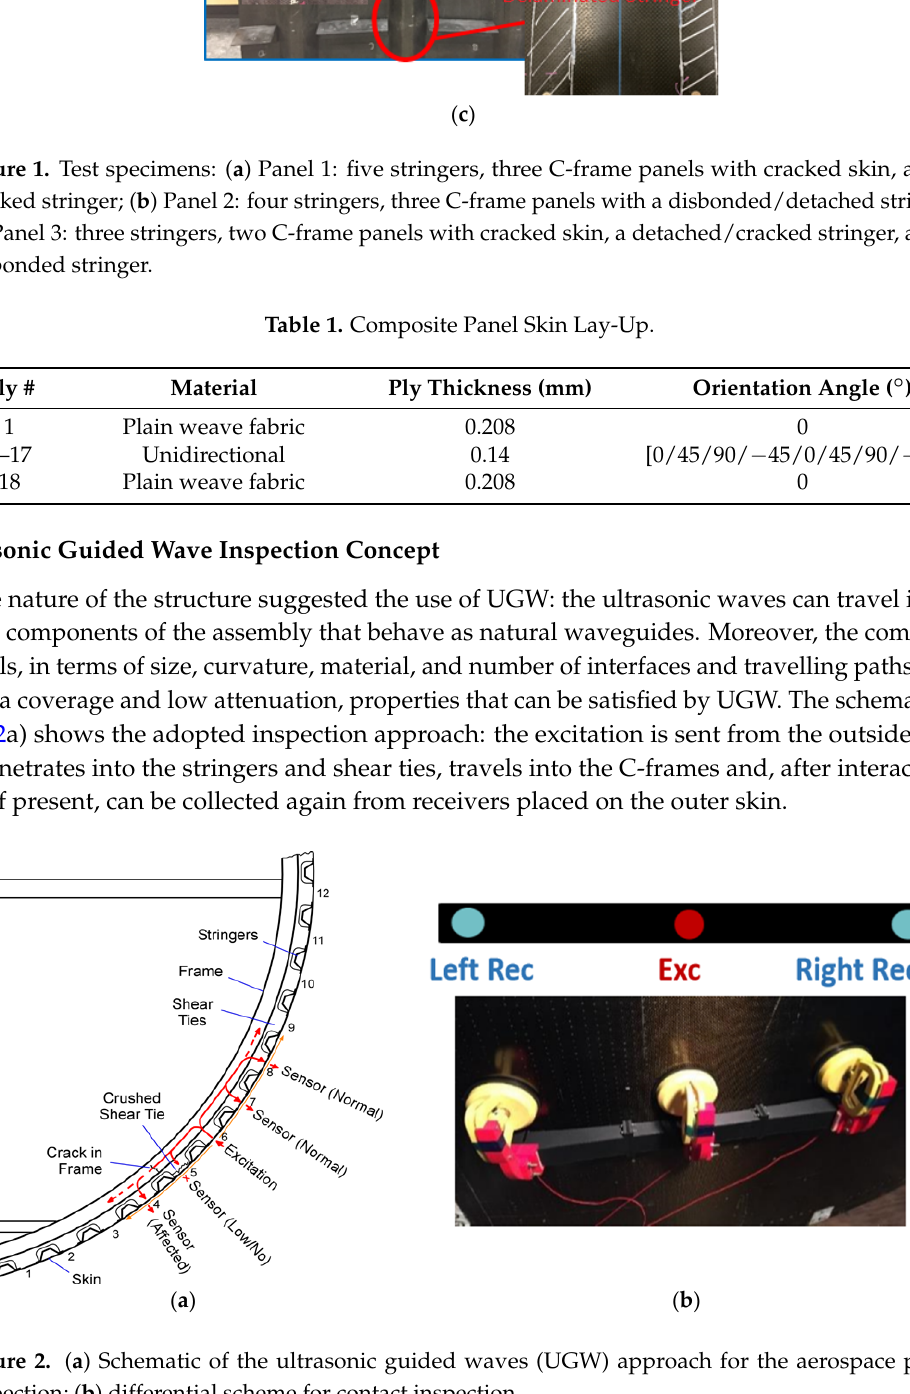
Figure 2. ( a ) Schematic of the ultrasonic guided waves (UGW) approach for the aerospace panel inspection; ( b ) differential scheme for contact